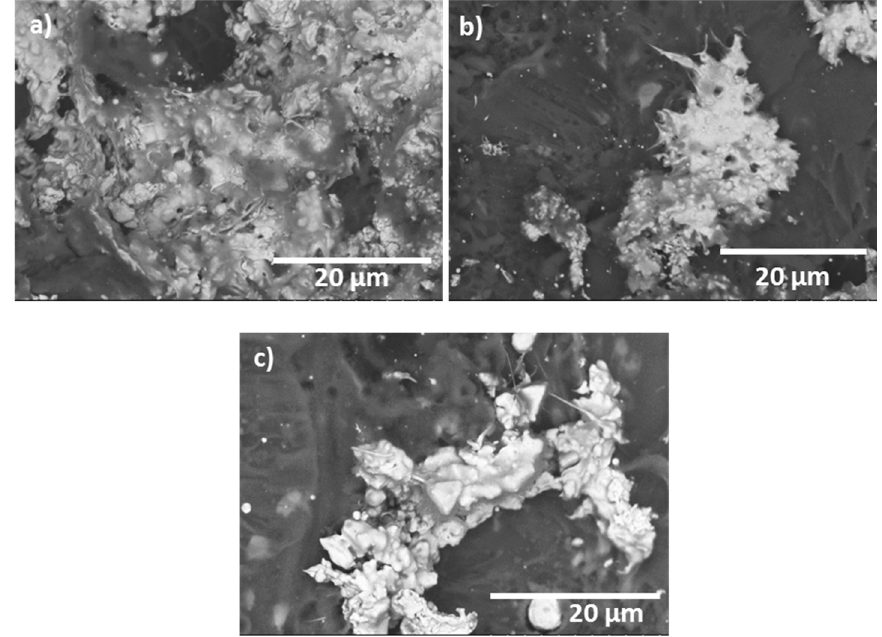
Figure 2. SEM micrographs in the backscattering electron mode of individual sprayed particles of the feedstock powder obtained from the wipe test. ( a ) Particle deformed after impact, ( b ) and ( c ) splash splat with little fingers.